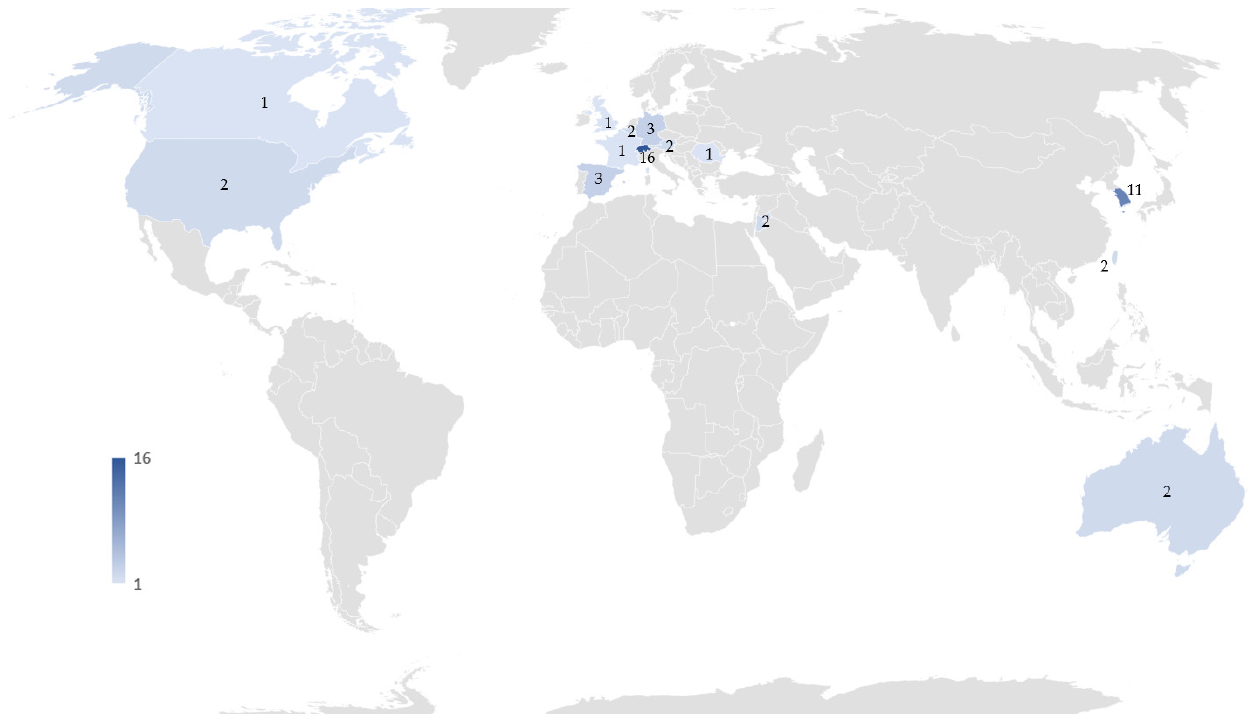
Figure 3. Location of the analyzed case studies (number of sites).